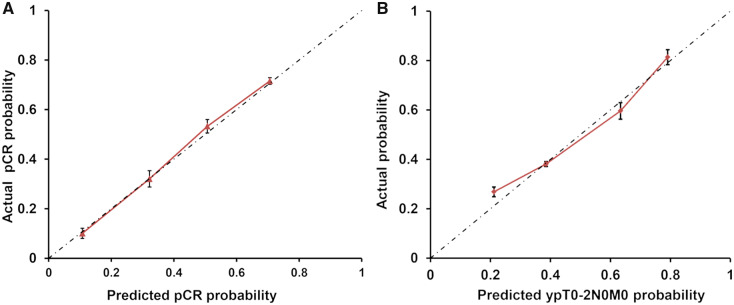
Calibration plots of the predicted and observed probabilities of pathological complete response (pCR) and good response (ypT0-2N0M0). (A) The prediction calculated using the nomograms is plotted on the x-axis and the observed rate of pCR is plotted on the y-axis. (B) The prediction calculated using the nomograms is plotted on the x-axis and the observed rate of tumor downstaging is plotted on the y-axis.